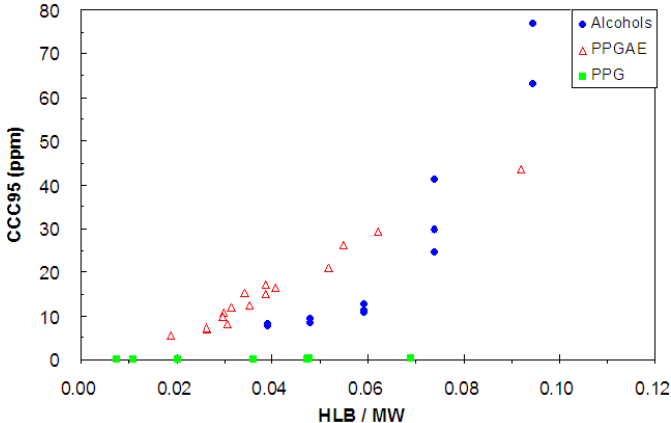
Figure 7. CCC95 (ppm) versus HLB/molecular weight for the 36